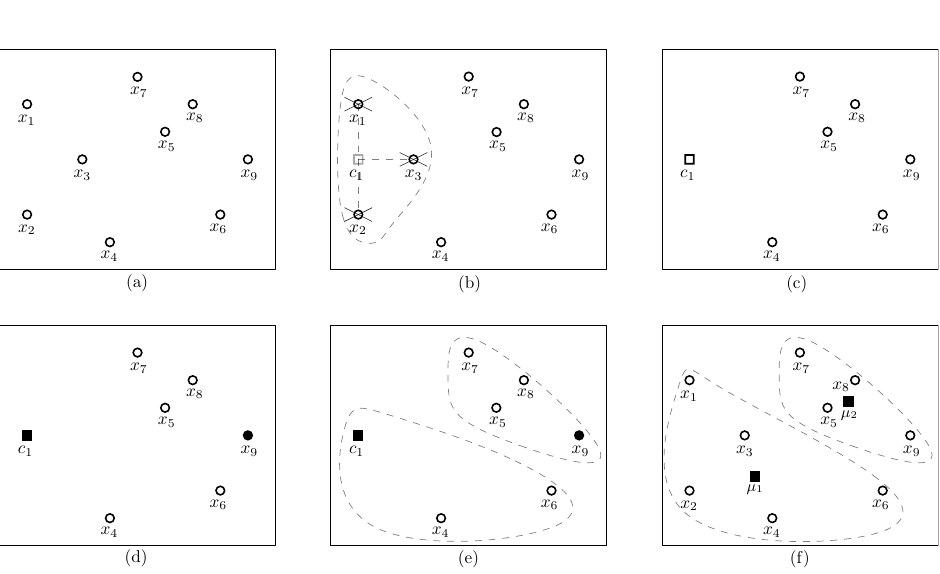
Figure 3. An example of executing Algorithm 1: ( a ) the set of data points; ( b ) Execution for must- links where c represents the must-link set { x 1 , x 2 , x 3 } as in ( c ); ( d ) the two centers selected; ( e ) the clustering results; ( f ) the calculated means according to the